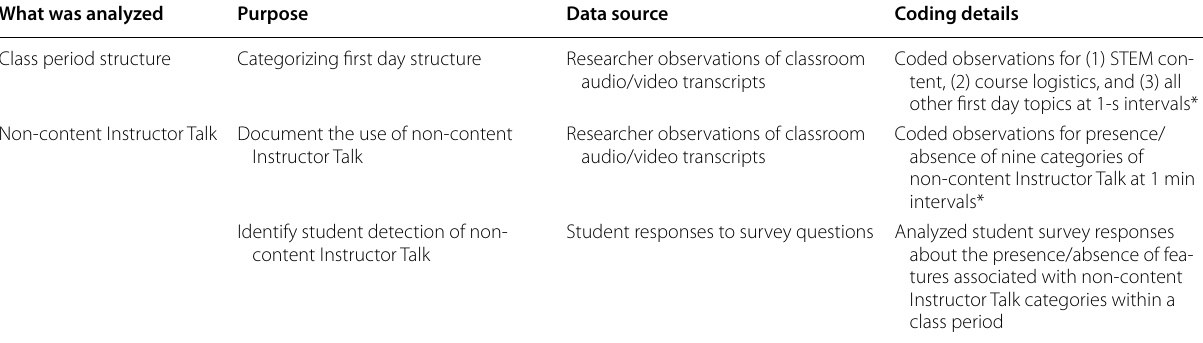
*Codebooks are available in Additional file 1: Appendix S1 and S2.